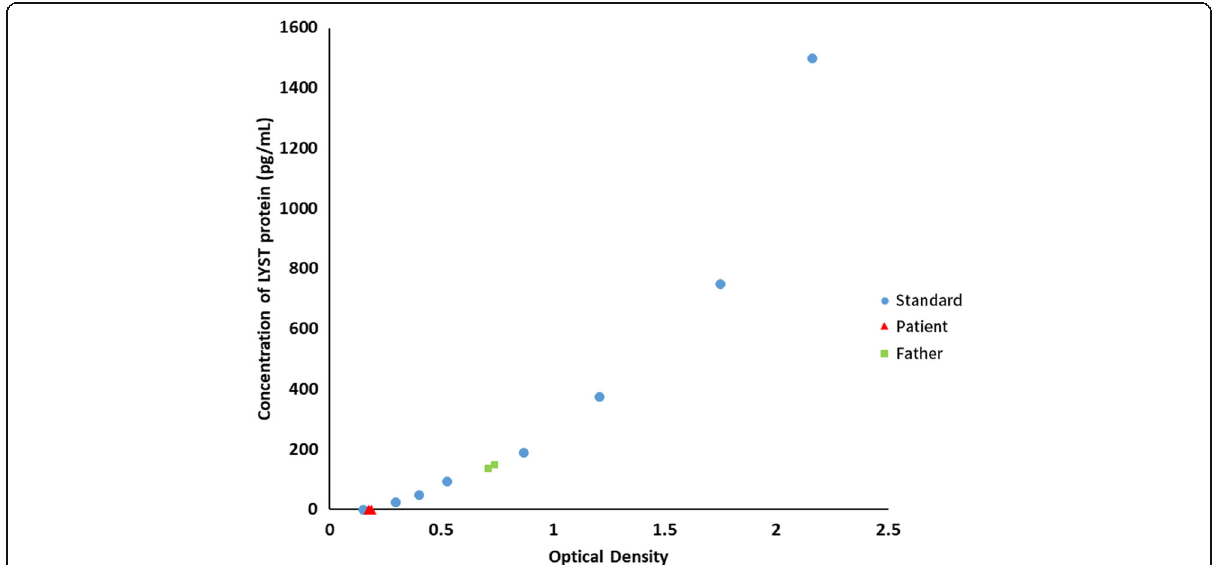
Fig. 3 ELISA test for human LYST protein. Dot: Standards provided in the ELISA kit. Triangle: Plasma sample from the patient. Square: Plasma sample from the patient ’ s